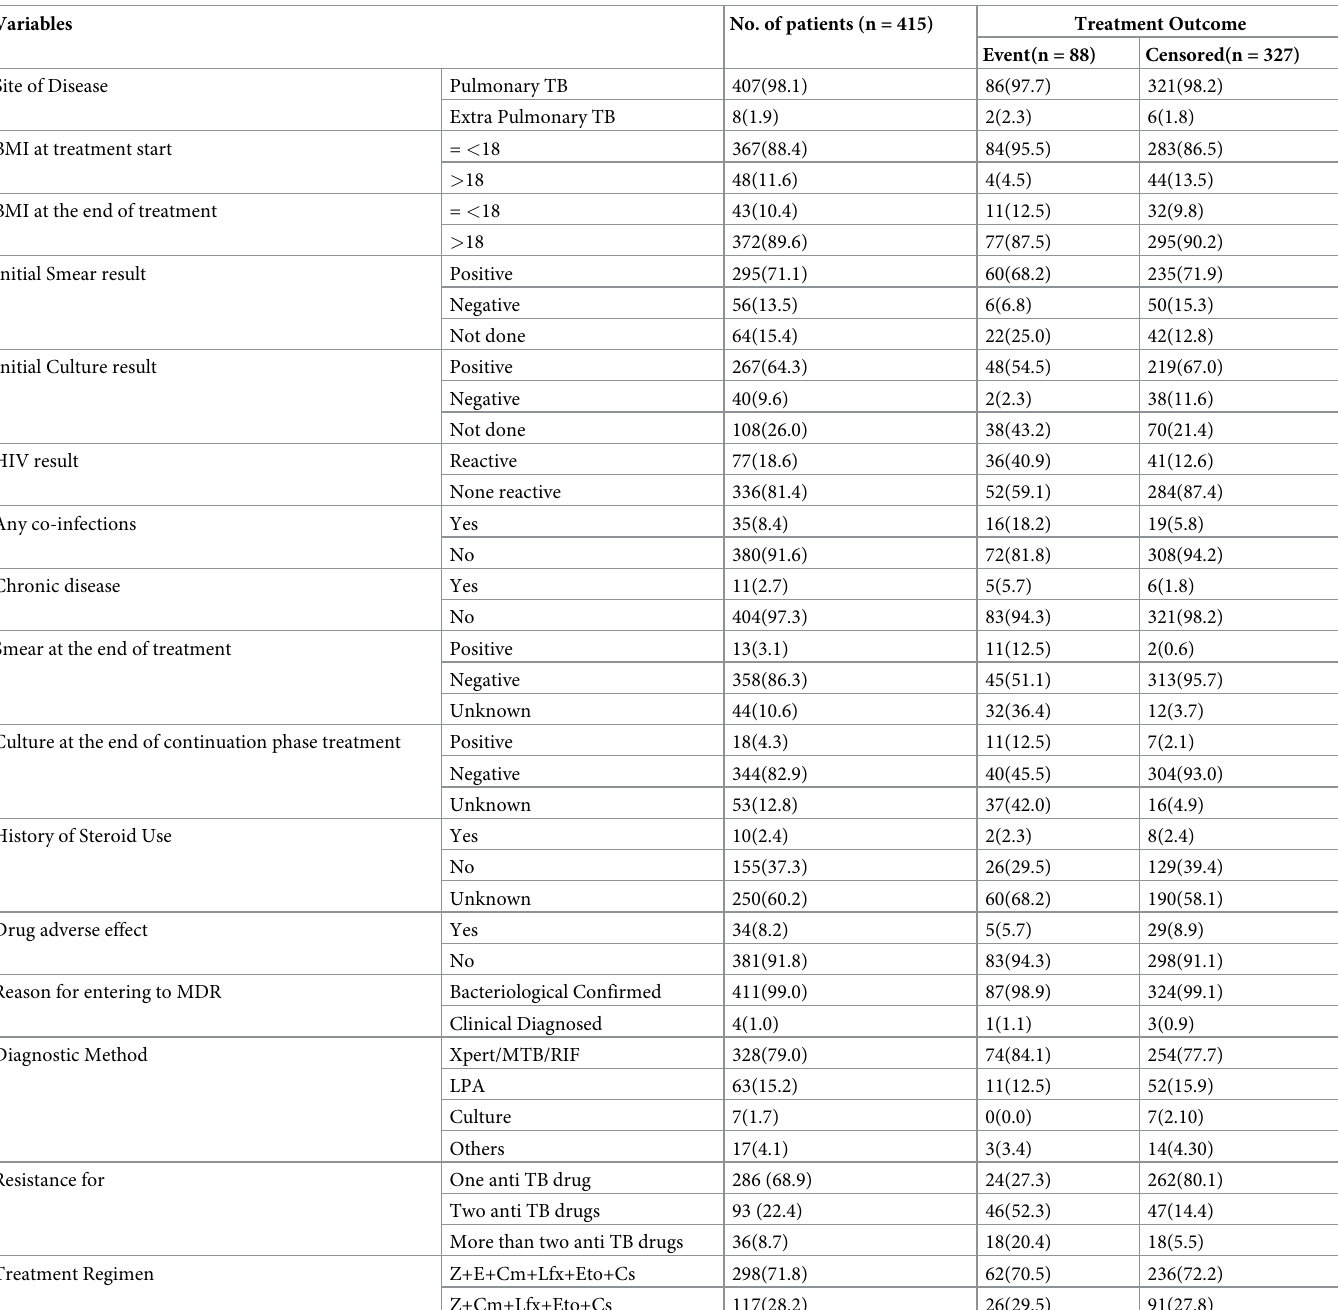
Table 2. Clinical characteristics of MDR-TB patients stratified by treatment outcome in Oromia hospitals from 2012 to 2017, Oromia Ethiopia.